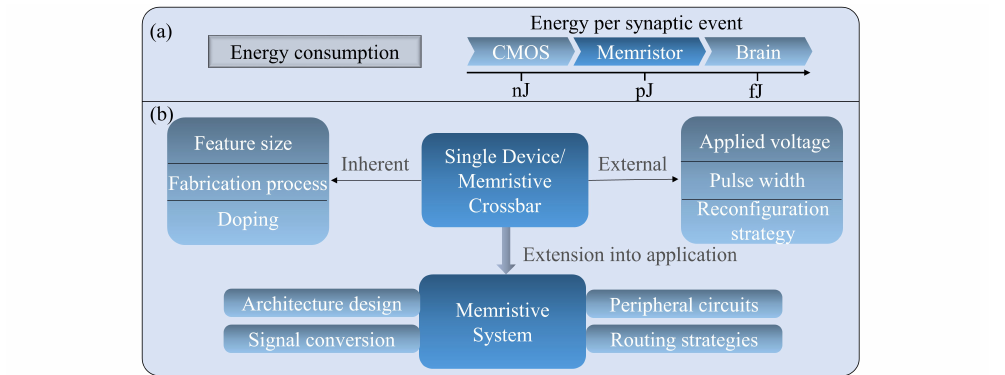
Figure 6. ( a ) Energy per synaptic event among CMOS, memristive device, and the brain; ( b ) Factors contributing to the energy consumption of single memristive devices and memristive